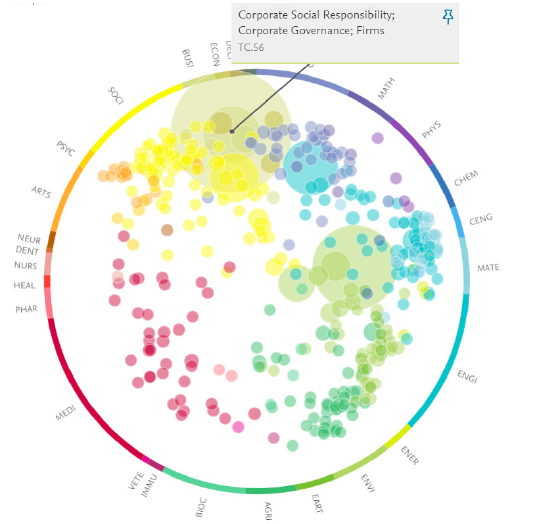
Figure 1. Cluster analysis results for the research areas related to ESG, SRI, sustainability and conventional (traditional) indices in